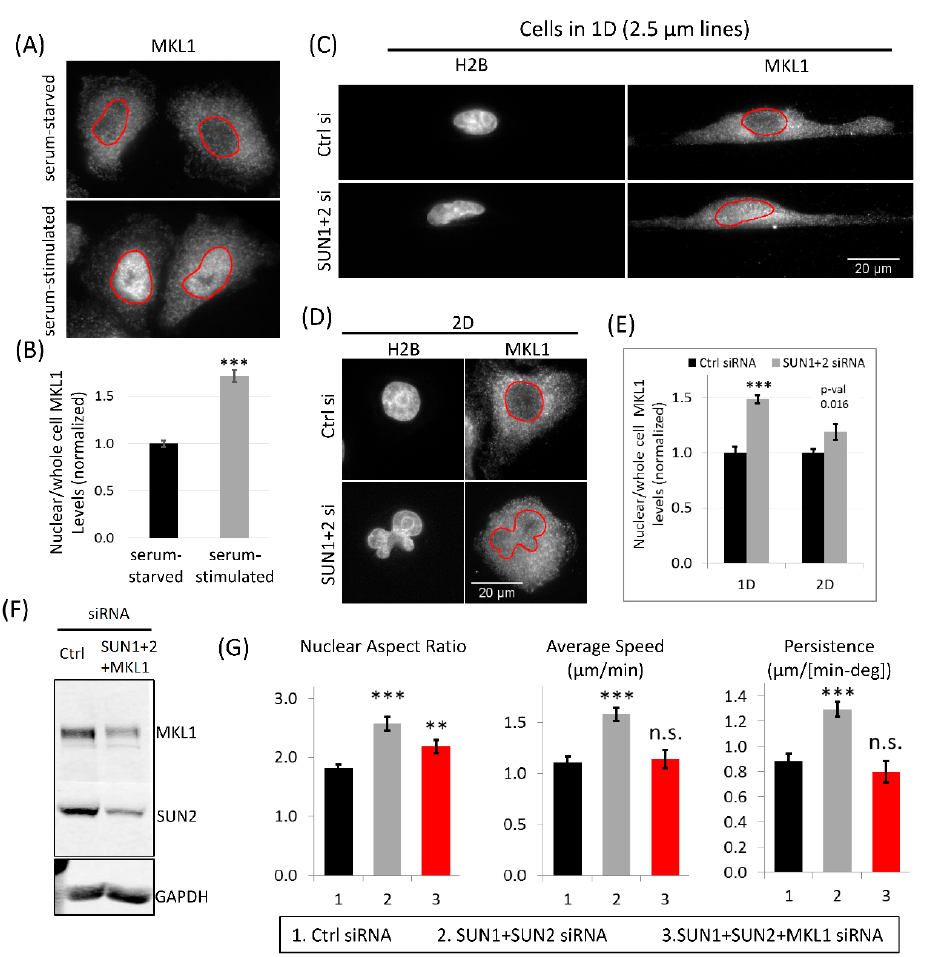
Figure 7. MKL1 is required for increased 1D tumor cell migration after SUN 1 + 2 KD. ( A ) MTLn3 carcinoma cells were stained with MKL1 antibody in serum-starved or serum stimulated conditions in 2D. Images show robust MKL1 nuclear translocation after serum stimulation (5% FBS for 5 min). Red outlines show nucleus boundary. ( B ) Quantification of nuclear/whole cell MKL1 levels in serum-starved or serum-stimulated MTLn3 carcinoma cells. Data normalized to steady state column and plotted as mean ± SEM, n = 30 cells (steady state condition) and 35 cells (serum stimulated condition), *** p value<0.001. ( C ) Images of control siRNA or SUN1 + 2 siRNA treated H2B-MTLn3 cells migrating on 2.5 µm micropatterned 1D lines, stained with MKL1 antibody to show the nuclear MKL1 translocation after SUN1 + 2 KD. Red outlines show nucleus boundary. ( D ) Images of control siRNA or SUN1 + 2 siRNA treated H2B-MTLn3 cells migrating in 2D, stained with MKL1 antibody to show the nuclear MKL1 translocation after SUN1 + 2 KD. Red outlines show nucleus boundary. ( E ) Quantification of nuclear/whole cell MKL1 levels in control or SUN1 + 2 siRNA treated cells migrating in 1D or 2D. Data normalized to Ctrl siRNA columns and plotted as mean ± SEM, n = 15 cells (1D, Ctrl siRNA), 15 cells (1D, SUN1 + 2 siRNA), 37 cells (2D, Ctrl siRNA), and 24 cells (2D, SUN1 + 2 siRNA), *** p value<0.001. ( F ) Western blots showing knockdowns of SUN2 and MKL1 in tumor cells treated with either control siRNA or SUN1 + SUN2 + MKL1 siRNAs. ( G ) Quantifications of nuclear aspect ratio, average tumor cell speed and tumor cell persistence after SUN1 + SUN2 + MKL1 KD in cells migrating in 1D. Data plotted as mean ± SEM, n = 20 cells for the SUN1 + SUN2 + MKL1 siRNA condition, ** p -value < 0.01, *** p value < 0.001, n.s. not significant. Control and SUN1 + 2 siRNA bars are shown here from Figure 6E–G for comparison.